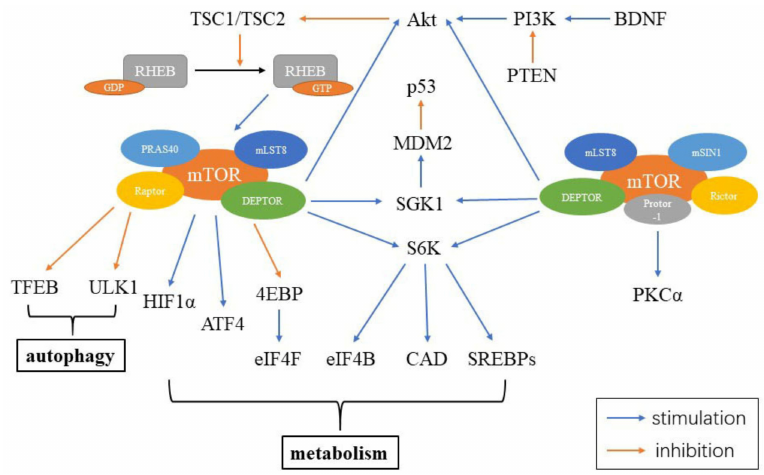
Figure 3. Constituents of mTORC and mTOR signaling in the cell. mTORC1 includes mTOR,